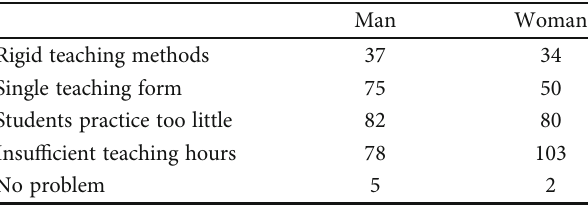
Table 3: Analysis of problems existing in the teaching method of level teacher.